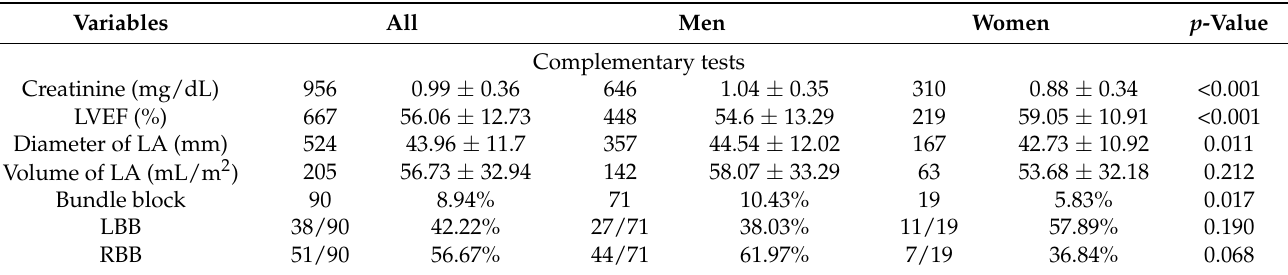
Table 2. Complementary